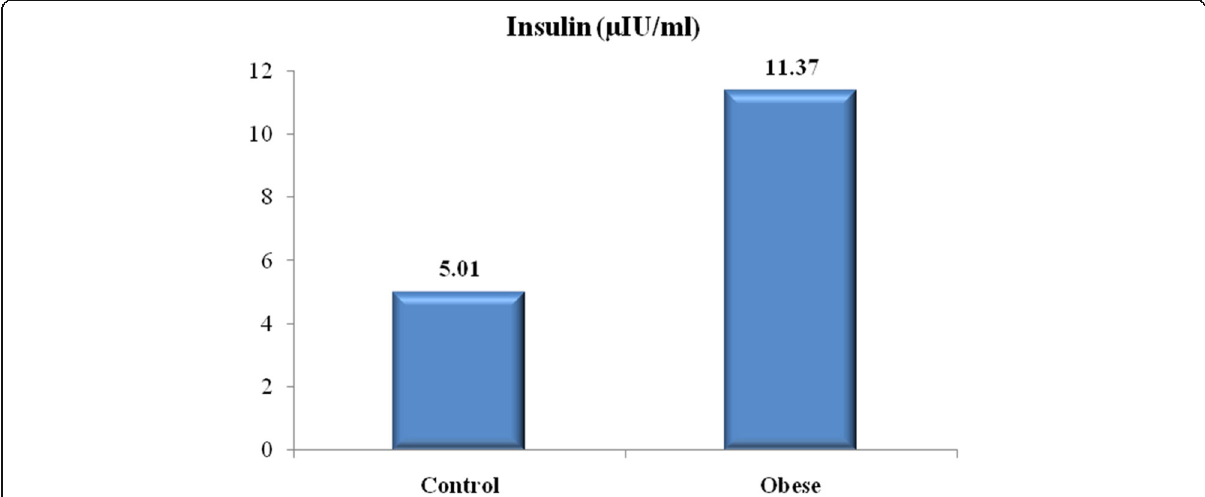
Fig. 2 Comparison of insulin levels between control and obese